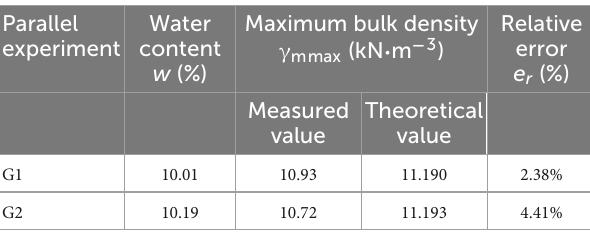
TABLE 5 The verification results of the model of the relationship between the soil water content and the maximum bulk density. Parallel